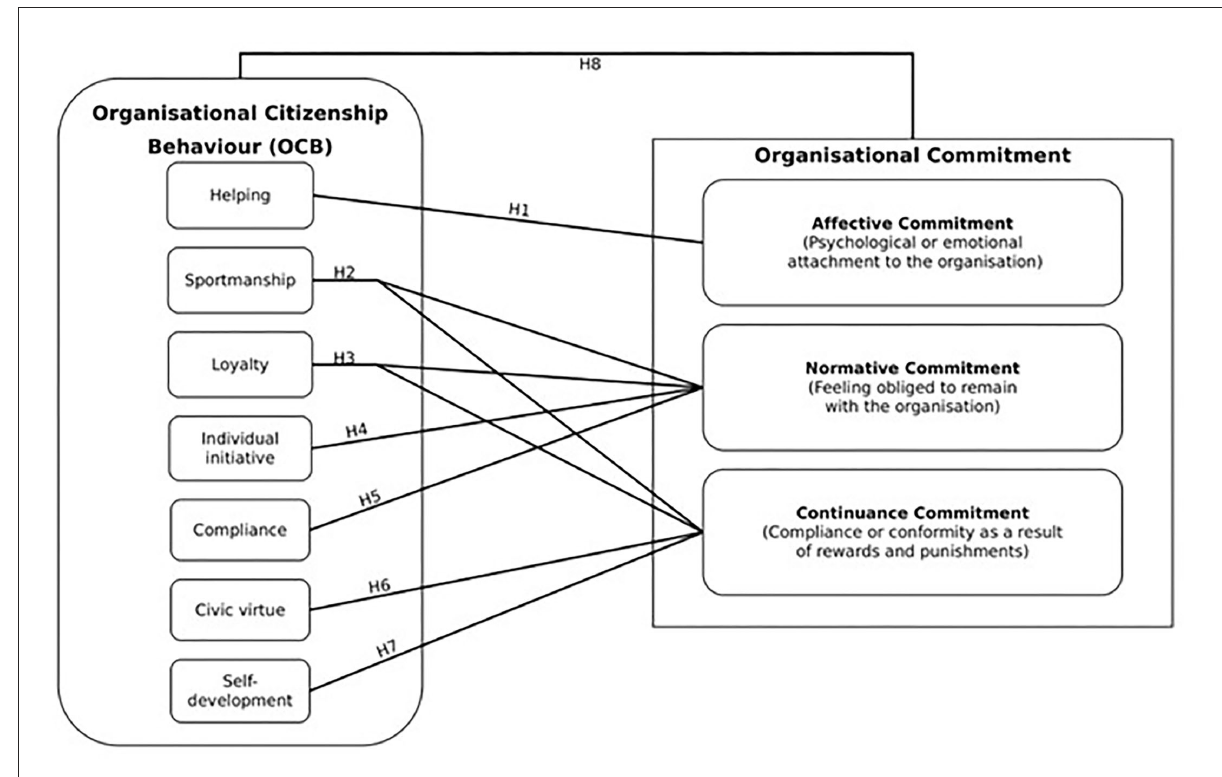
FIGURE1 The research